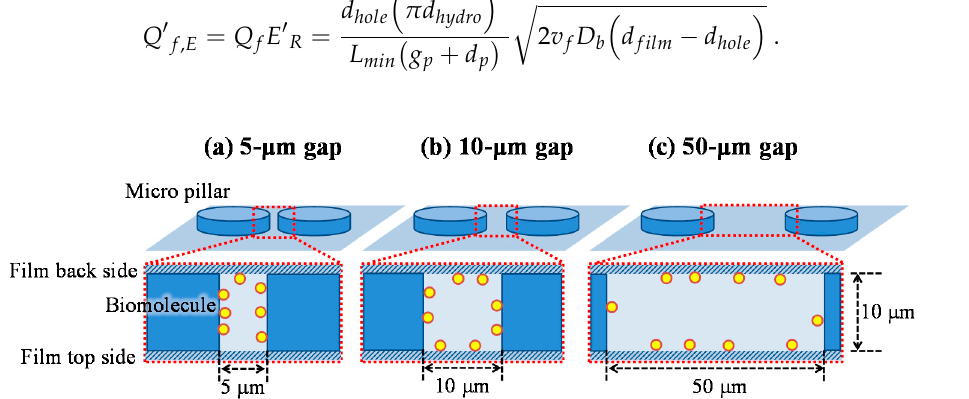
Figure 11. Schematic image of the situation indicating that the biomolecule adsorption on the wall in the space between films of the film-stack reaction field. ( a ) 5-µm gap. ( b ) 10-µm gap. ( c ) 50-µm gap.